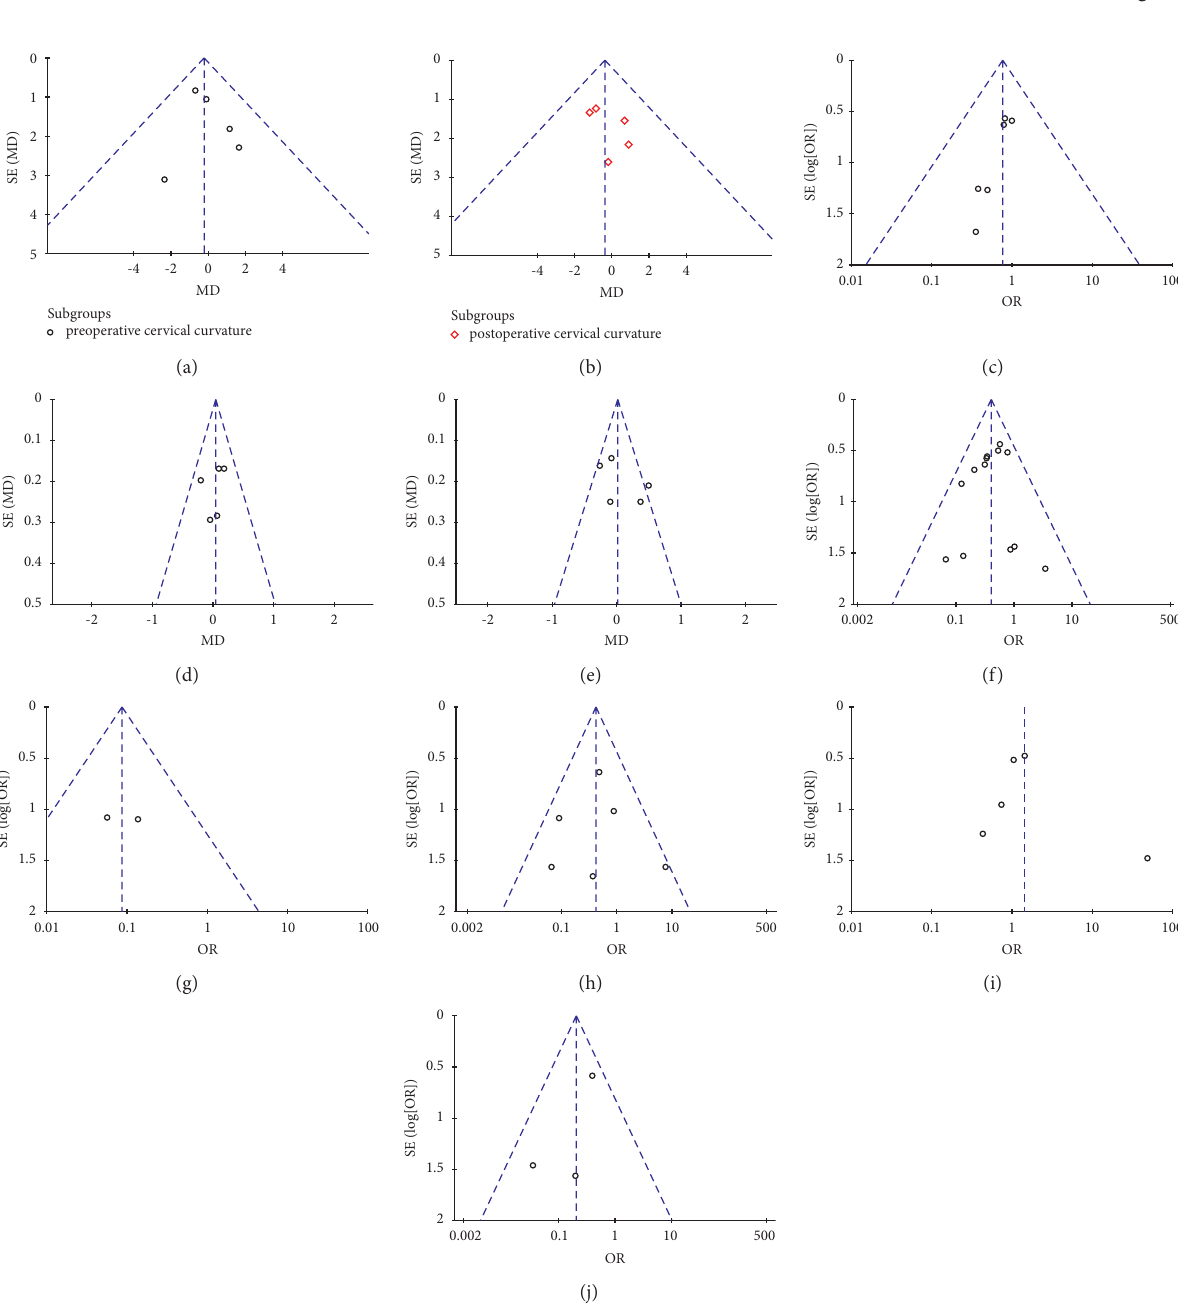
Figure 1: (a) Preoperative cervical curvature funnel diagram; (b) postoperative cervical curvature funnel diagram; (c) funnel diagram for interbody fusion rate; (d) preoperative DHI funnel diagram; (e) postoperative DHI funnel diagram; (f) postoperative dysphagia funnel diagram; (g) ALOD funnel diagram; (h) ASD funnel diagram; (i) postoperative sinking rate funnel diagram of fusion cage; (j) screw loosening funnel diagram (IV) evaluation of publication